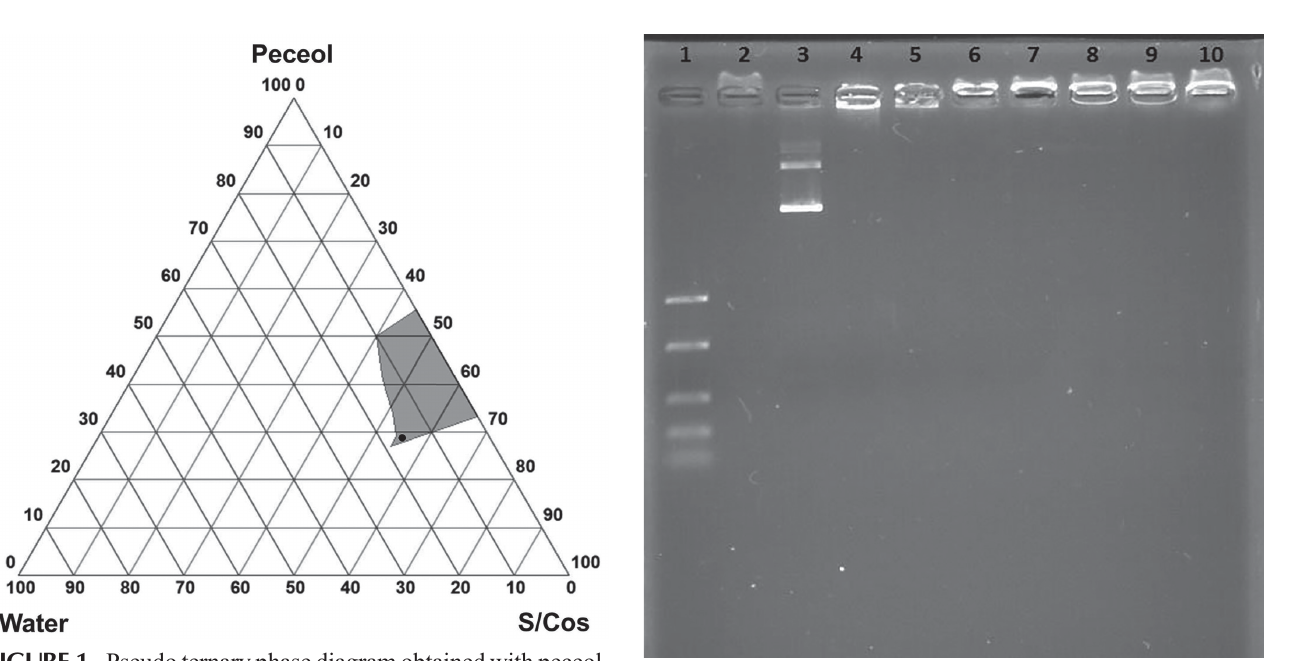
FIGURE 2 - Agarose gel photograph showing SLN complexation. Lane 1: GeneRuler 1 kb DNA ladder; Lane 2: SLN; Lane 3: naked DNA as control; Lane 4: SLN:DNA 1:1; Lane 5: SLN:DNA 2:1; Lane 6: SLN:DNA 3:1; Lane 7: SLN:DNA 4:1; Lane 8: SLN:DNA 5:1; Lane 9: SLN:DNA 7:1; Lane 10: SLN:DNA 10:1.